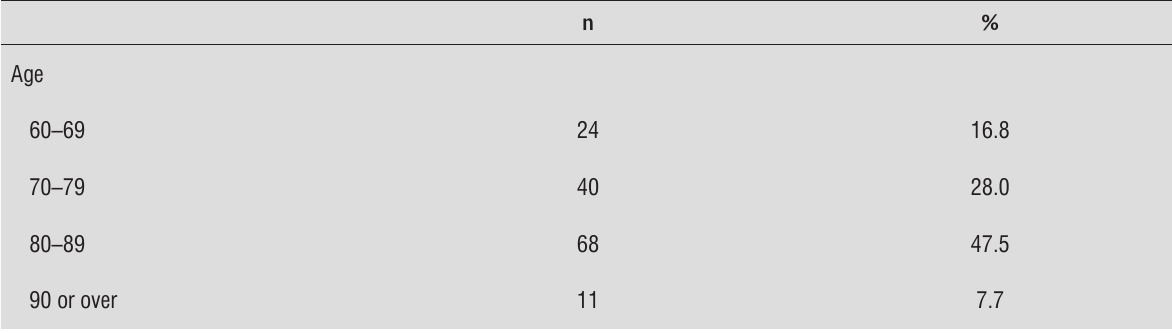
Table 1 - Socio-demographical and health-related information – Natal (RN),